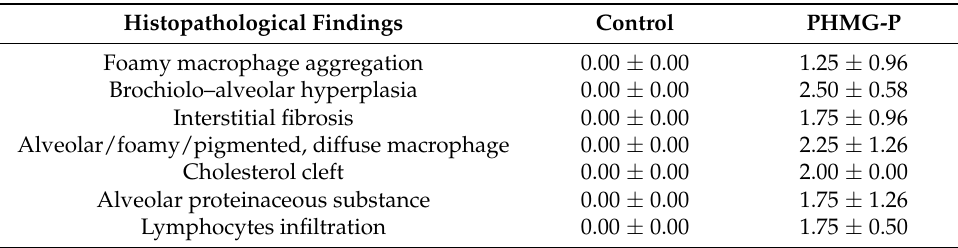
Table 1. Quantitative histopathologic evaluation of lung tissues in the PHMG-P-treated and the control groups.